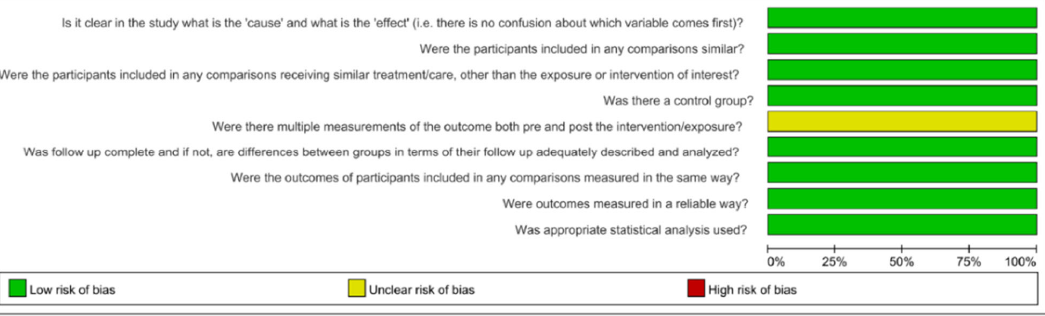
Figure 3. Risk ‐ of ‐ bias graph.